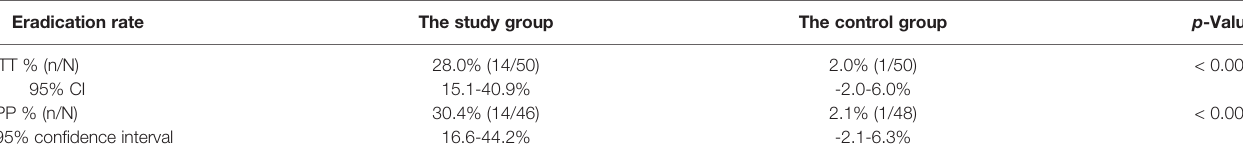
TABLE 3 | The eradication rate of the fi rst stages of treatment.